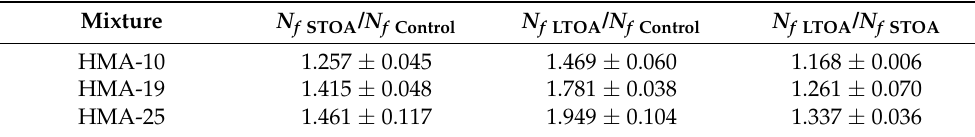
Table 4. Ratio between N f of control mixes, STOA and LTOA.